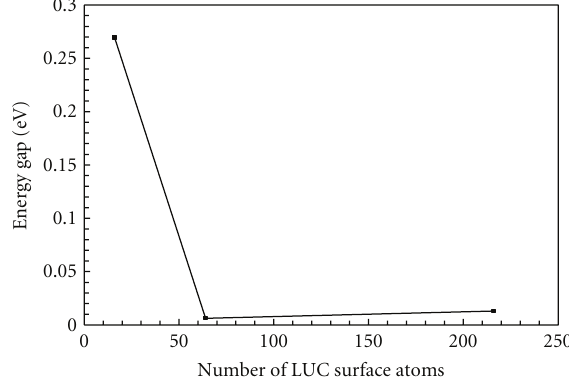
Figure 11: Energy gap of AlP nanocrystals oxygenated face as a function of surface area of nanocrystals facet.